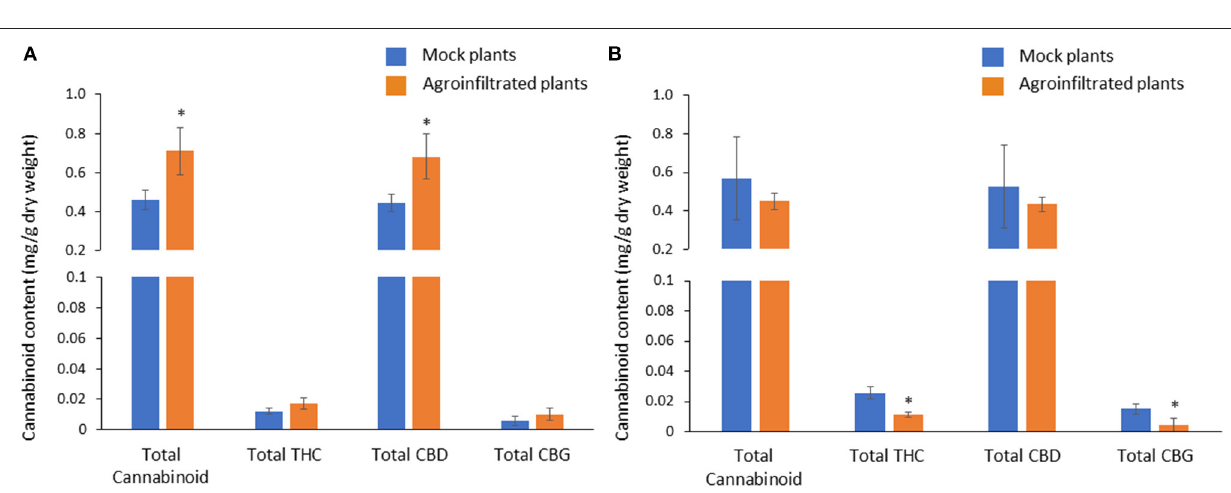
FIGURE 7 | Comparison of cannabinoid contents between mock and agroinfiltrated plants in CBDAS overexpressed female flowers (A) and THCAS silenced female flowers (B) . The cannabinoid contents were quantified with HPLC. Data is presented as mean ± S.E. *Indicates statistically significant differences at P < 0.05 compared with mock plants, according to the statistical analysis in paired t